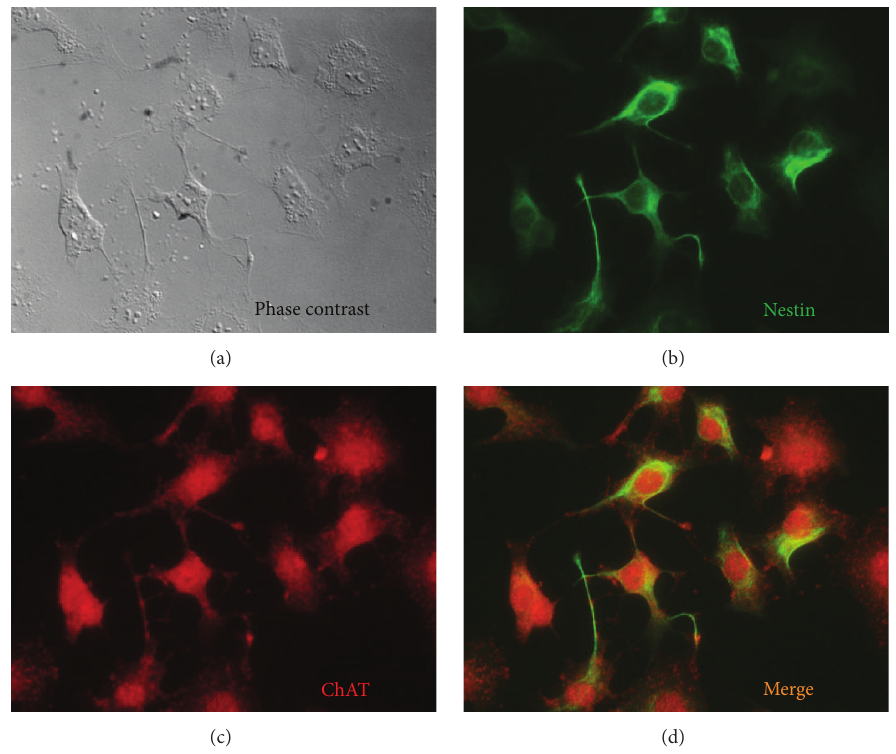
Figure 1: Establishment and immunophenotyping of F3.ChAT human neural stem cell line. (a) A phase contrast image of F3.ChAT cells. (b) Immunocytochemical identification of nestin protein (green) in F3.ChAT cells. (c) Immunocytochemical identification of choline acetyltransferase (ChAT) protein (red) in F3.ChAT cells. (d) Merge of nestin- (b) and ChAT-positive (c)